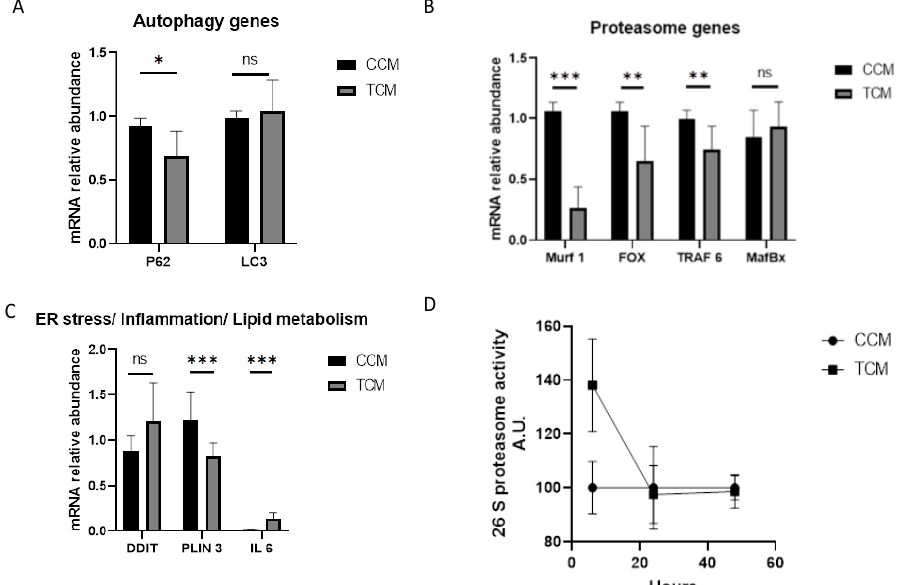
Figure 3. Change in mRNA expression in human primary myotubes incubated with either control- conditioned media (CCM) (n = 3 replicates) or with tumor-conditioned media (TCM) (n = 3 replicates). ( A – C ) Change in mRNA expression in human differentiated myotubes incubated for 48 h with either CCM or TCM. Gene expression in each condition was normalized to GAPDH expression. *: p < 0.05, **: p < 0.01, and ***: p < 0.001. ( D ): Time–course of proteasome activity in human-differentiated myotubes incubated with either CCM or TCM for different time-points (6 h, 24 h, and 48 h). ns: non